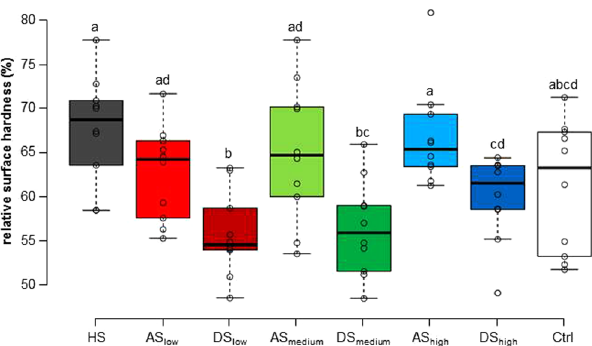
Figure 2. Final remaining relative SH after all experimental cycles for the different groups. SH decreased significantly less in the AS groups than in the corresponding DS groups, and SH decreased significantly less in the HS group than in all of the DS groups. Different letters indicate significant differences between the groups (Wilcoxon-Mann-Whitney test, p <